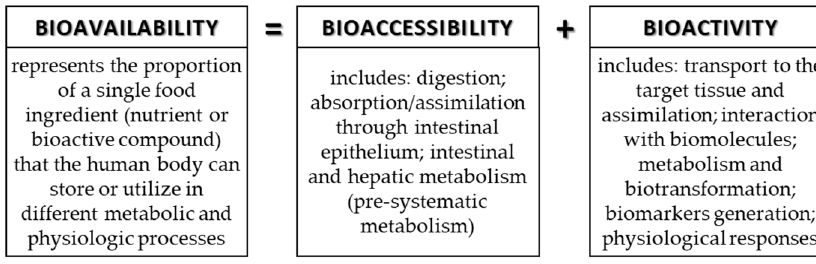
Figure 4. Connection of terms: bioavailability, bioaccessibility, and bioactivity.